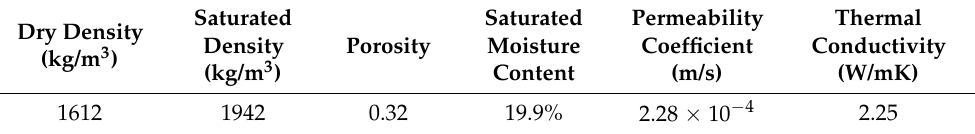
Table 1. Physical properties of sand.